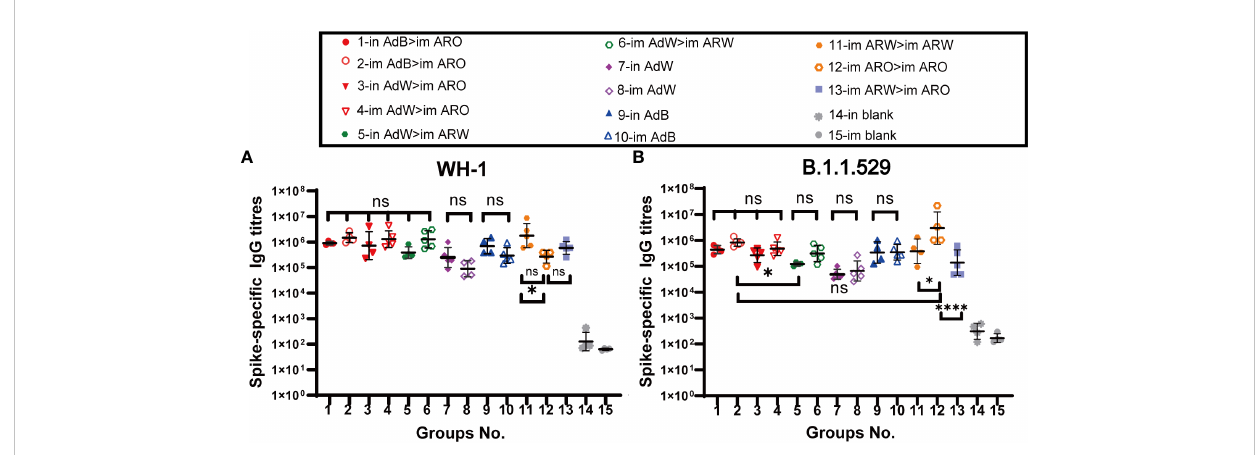
FIGURE 2 IgG responses induced by AdW, AdB, ARW, and ARO vaccines that were administered using various protocols. All titres were measured on day 35 after primary immunisation. Serum IgG titres against (A) WH-1 and (B) B.1.1.529 spike protein (n = 4 − 5 per group; each spot represents one sample). Bars represent the geometric mean ± geometric SD; *P < 0.05; ***P < 0.001; ns, P >